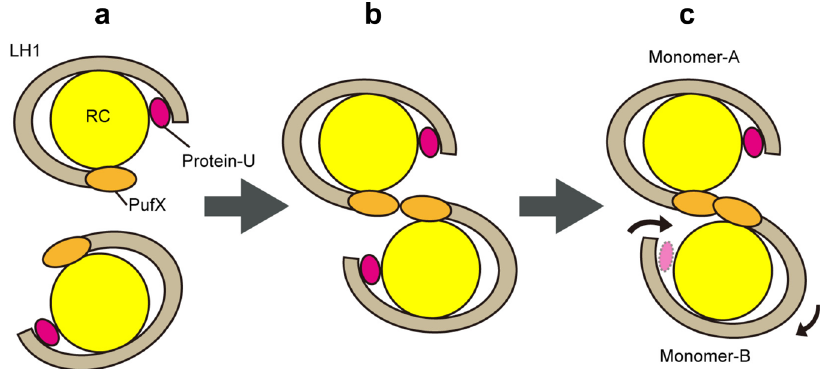
Fig. 7 Schematic docking model for the dimerization of LH1 – RC complex. Cartoon representation of the complexes viewed from the periplasmic side. a Two C-shaped LH1 – RC monomers before dimerization. b Dimerization of the monomers at an early stage with a symmetric S-shaped conformation. c Formation of an asymmetric junction is completed with breaking symmetry. Due to a wind-up movement of monomer B, most parts of protein-U are disordered and the LH1-ring opening is narrowed in monomer B. Thus, the sizes of LH1-ring opening are different to enhance asymmetric features. Because monomeric Δ U LH1 – RC complex lacks protein-U and only has a half-LH1 ring, it could not form a stable dimer. The color codes are RC: yellow, LH1 ring: gray, PufX: orange,